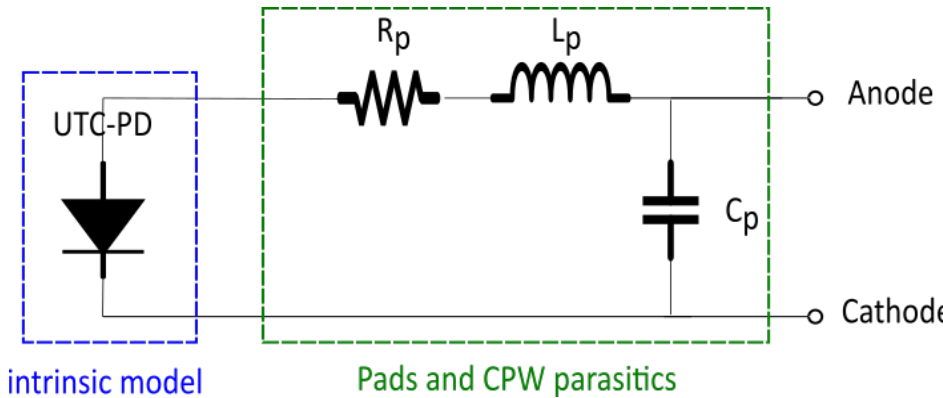
Figure 3. UTC-PD basic electrical equivalent circuit.